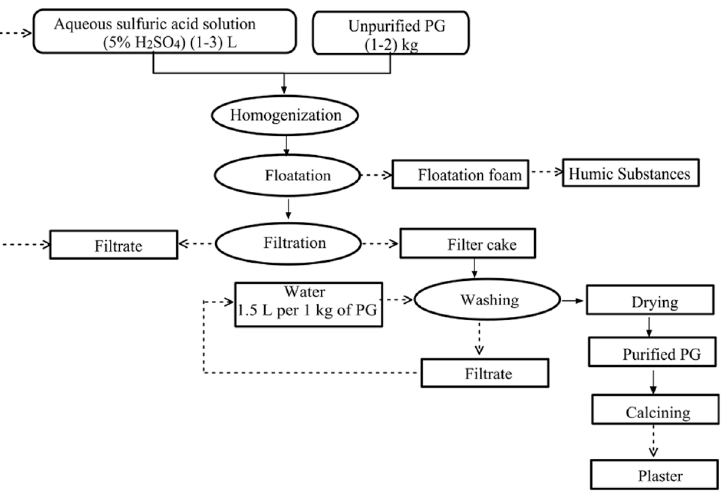
Figure 1. Flow chart of the purification process of PG with the sulfuric acid solution [22].